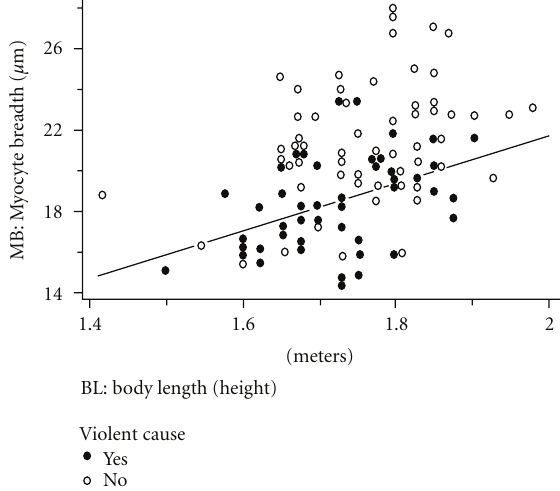
Figure 3: Each symbol presents two-dimensional means of a single left ventricle. The sloping line is fit only to the dots, omitting the circles and plots (2) ( r = 0 . 42). (For all 104 dots plus circles r = 0 . 67).